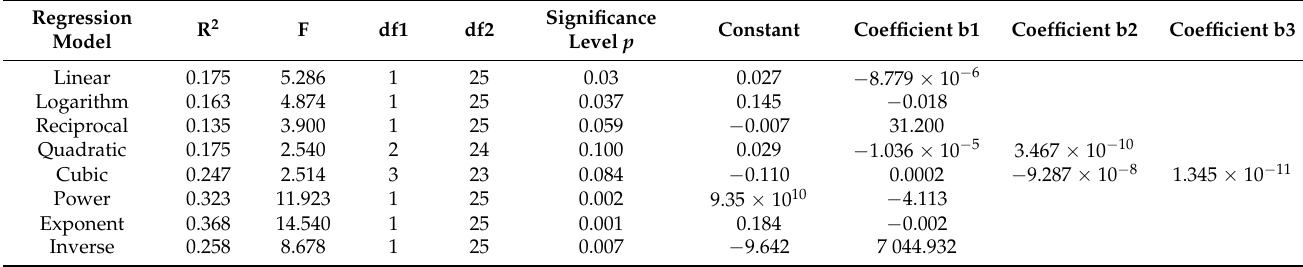
Table 3. Regression fitting model of travel rate and per capita travel